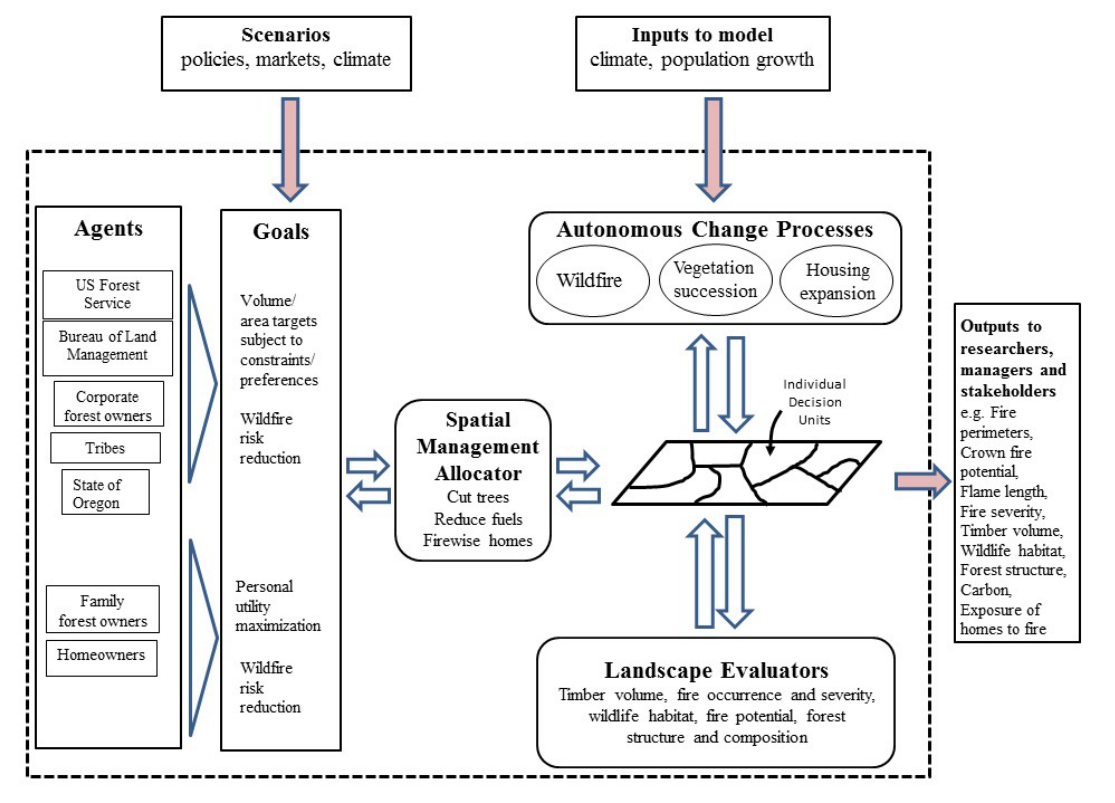
Fig. 2. Conceptual model of components and interactions of the Envision model for forest landscapes in the eastern Cascades of Oregon, USA. Agents (landowners) have different goals that are implemented through a spatial management allocator that changes the structure of the vegetation on individual management units. The landscape is also affected by autonomous change processes. The landscape is characterized at different points in time by metrics of fire and ecosystem services. See Spies et al. (2014) for more discussion of this conceptual